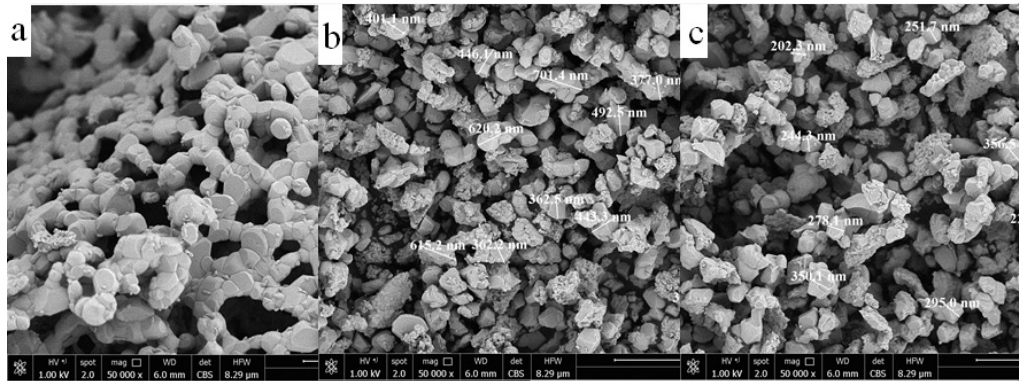
Figure 5. Scanning electron microscopy (SEM) images of LSC: ( a ) Ball milling (BM)-LSC (0 h); ( b ) BM-LSC (10 h); ( c ) BM-LSC (20 h).